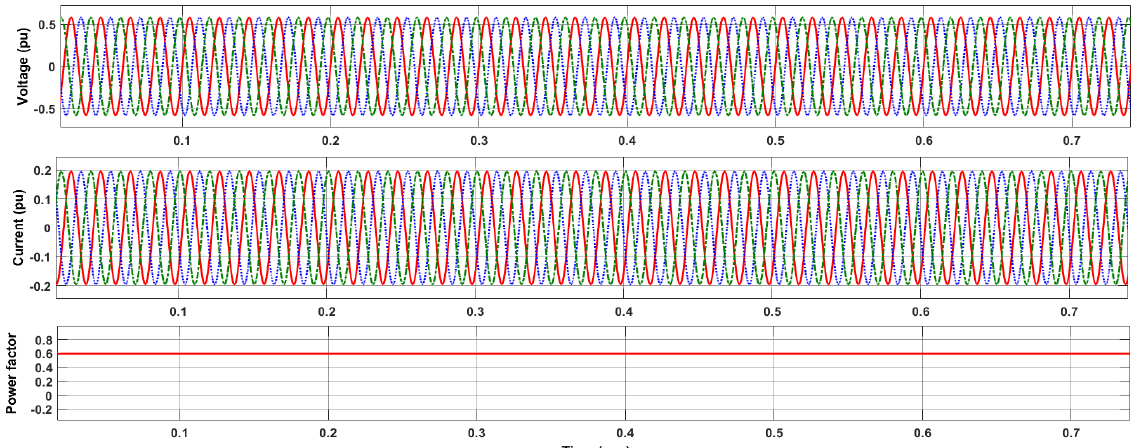
FIG. 8. VOLTAGE, CURRENT, AND POWER FACTOR PLOTS WITHOUT SVC (UN-COMPENSATED)